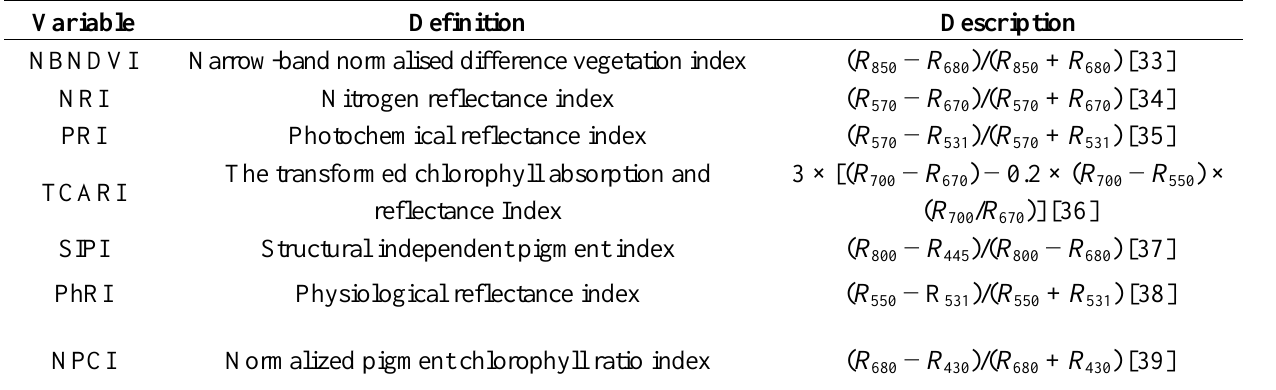
Table 1. Spectral vegetation indices used for the comparison of